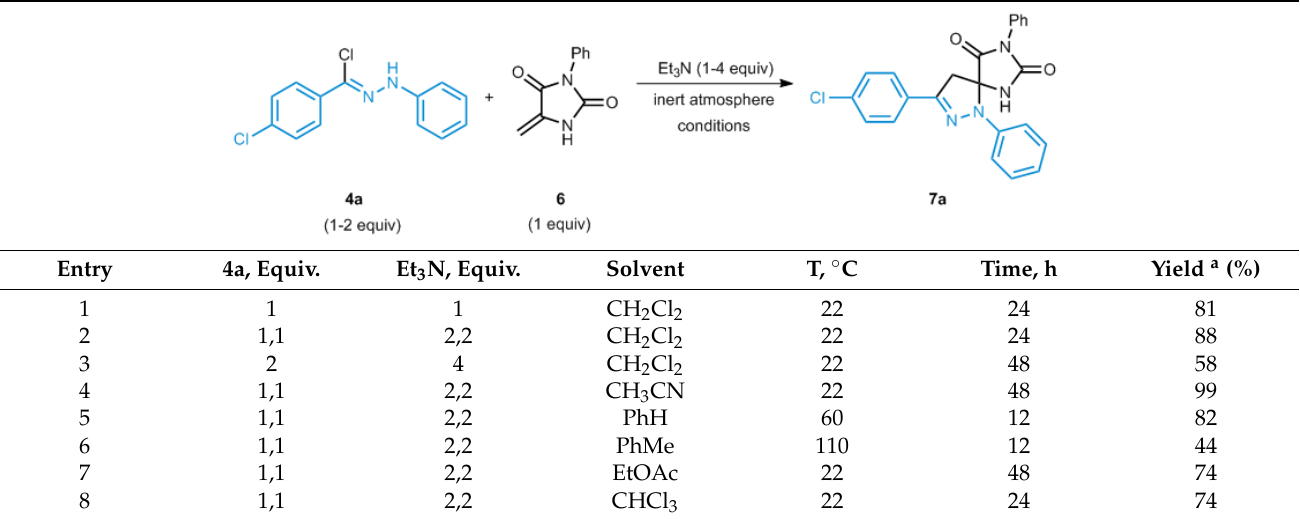
Table 1. Optimization of reaction conditions (for the hydrazonoyl chloride 4a interaction with